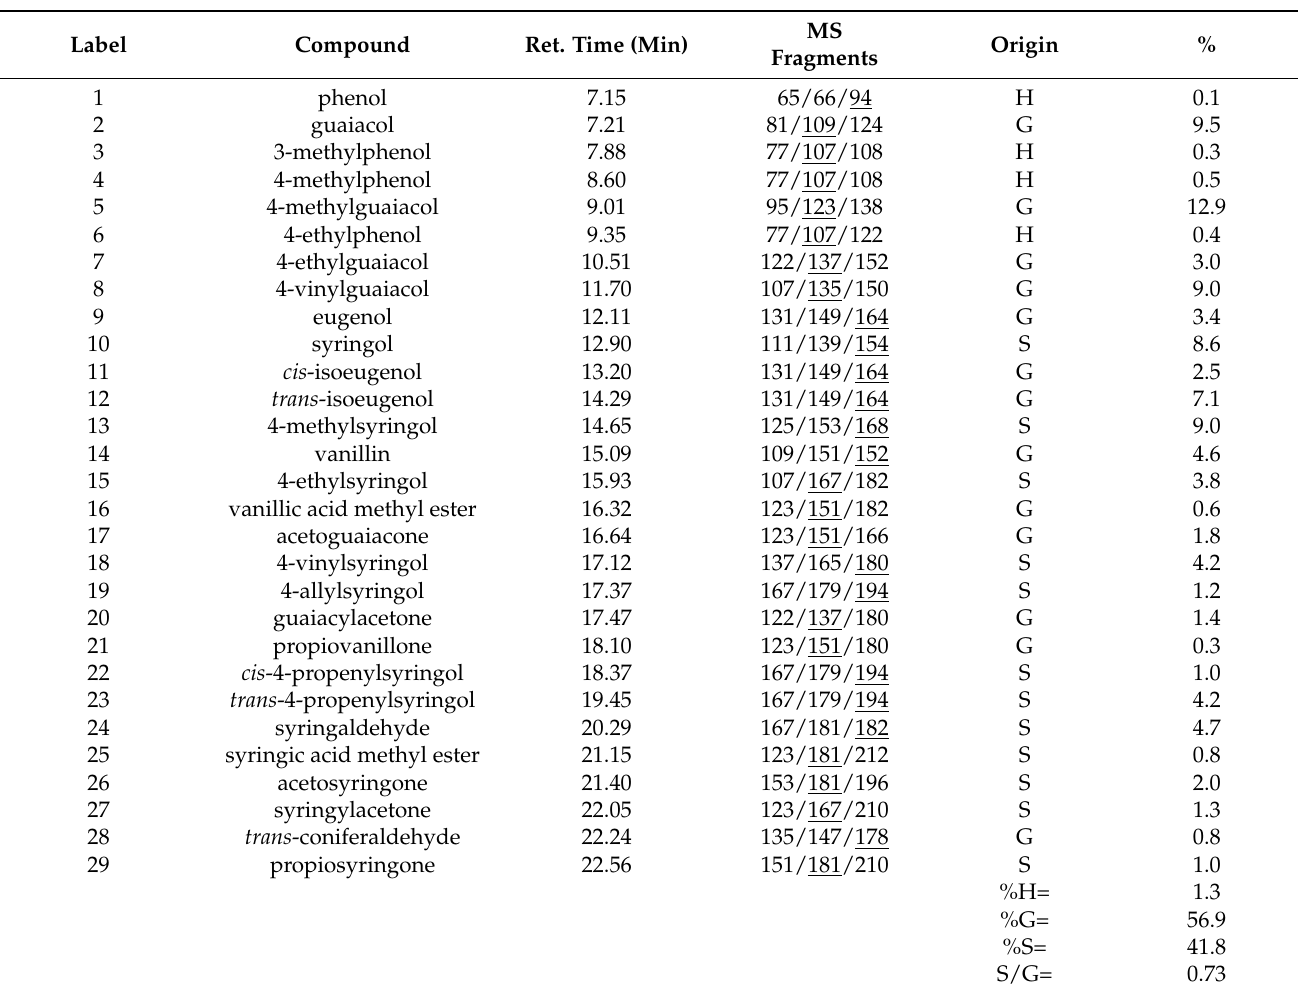
Table 2. Identities and relative molar abundances (%) of the phenolic compounds released upon Py-GC/MS of the OTP-MWL. The retention time, mass spectrometric fragments, and origin of the released compounds are